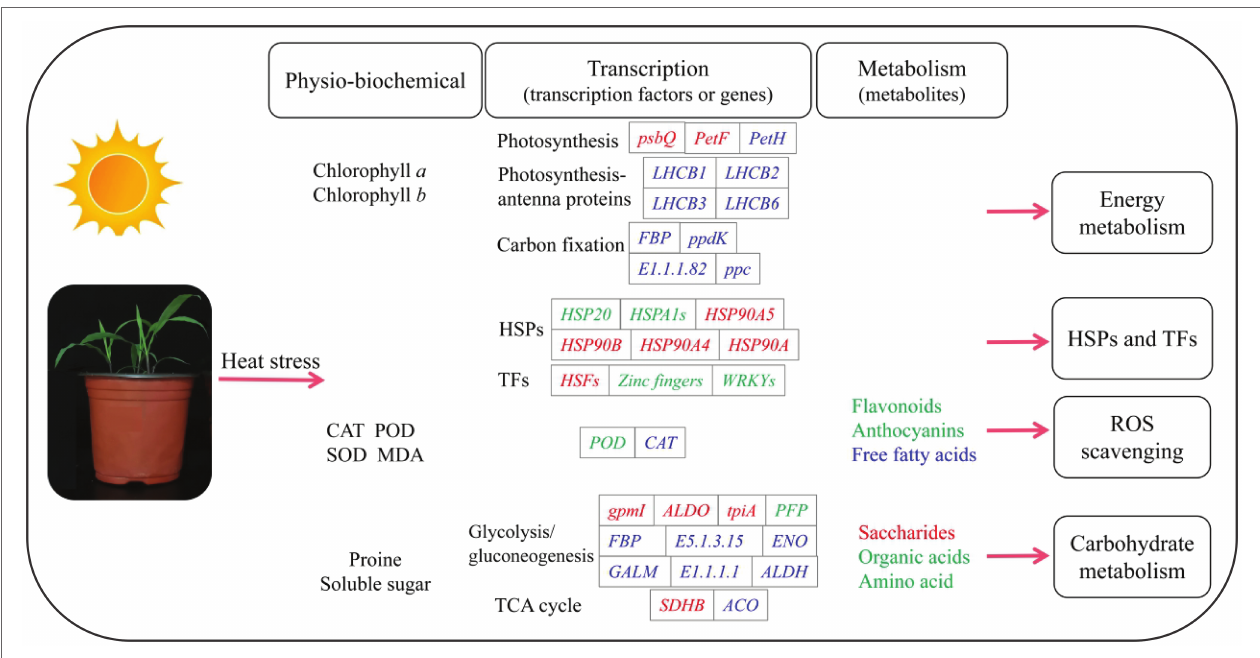
FIGURE 7 | A schematic diagram summarizing the responses to high-temperature stress in Paspalum wettsteinii . The changes of main indexes in Physio- biochemical, transcription, and metabolism are listed. The genes and metabolites in red, blue, or green letters refer to up-, down- and both up- and downregulated expression, respectively, in response to high